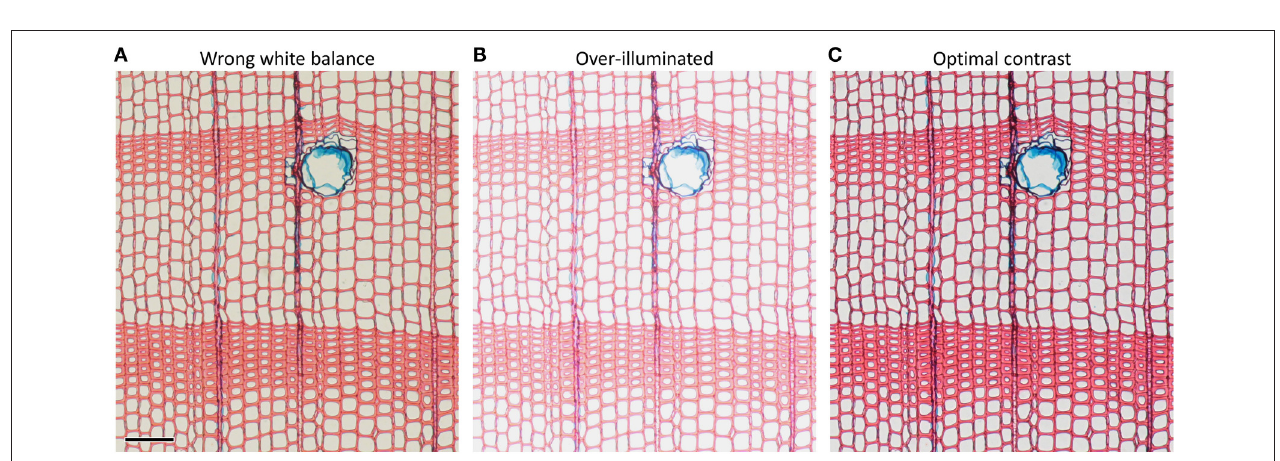
FIGURE 6 | Anatomical images of the same Pinus sylvestris microslide illustrating how imporper microscope settings such as (A) wrong white balance and (B) over-illumination reduce image contrast compared to (C) optimal settings. Suboptimal microscope settings may impede automatic detection of anatomical features and result in under- and over-estimation of anatomical features. Scale bar = 100 µ